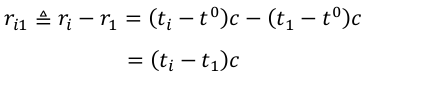
Figure 2: DecaWave’s DW1000 location and communication chip